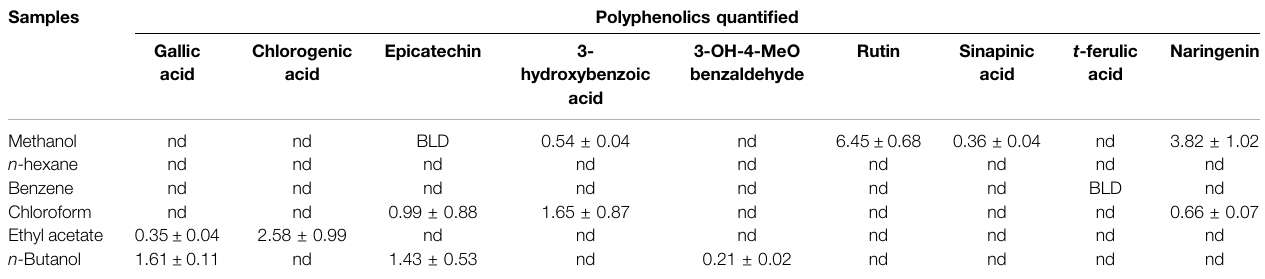
TABLE 2 | HPLC-PDA polyphenolic quanti fi cation of S. indicus extracts/fractions.